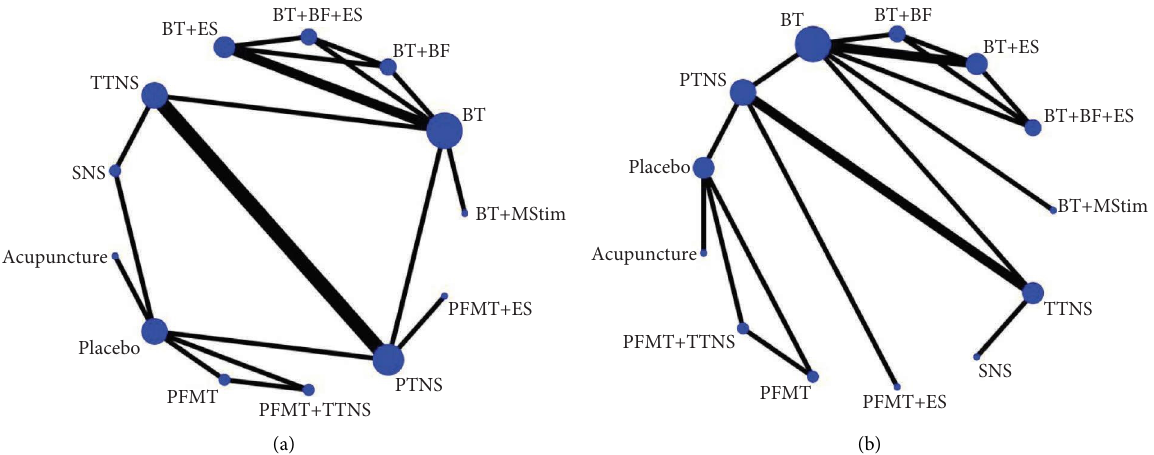
Figure 4: Network of the comparisons for the Bayesian network meta-analysis. (a) Network of the comparisons for the daytime micturition frequency. (b) Network of the comparisons for the nocturia